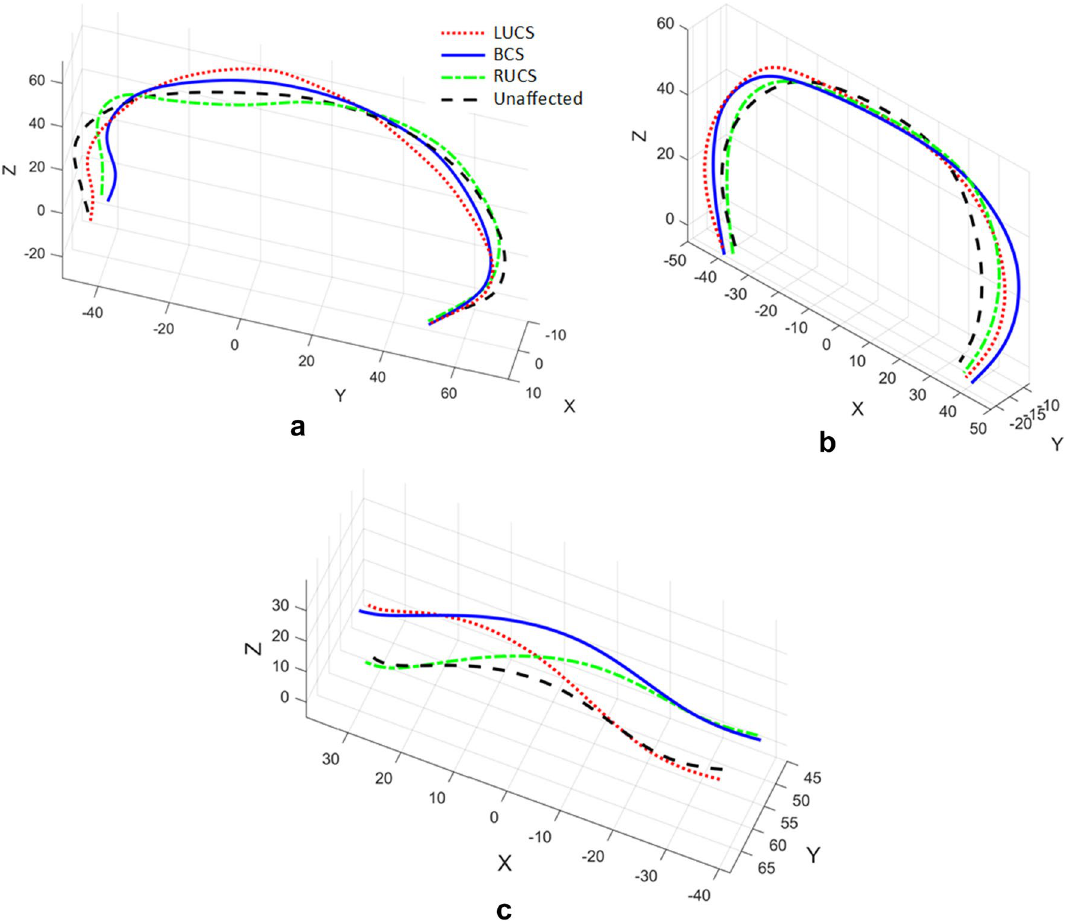
Figure 14. Mean shapes of ( a ) the sagittal curves, ( b ) the coronal suture, and ( c ) the lambdoid sutures of four groups: LUCS (red dotted line), BCS (blue solid line), RUCS (green dotted dashed line), and unaffected cases (black dashed line). Notice the symmetry of the suture curves about the skull symmetry plane (X =